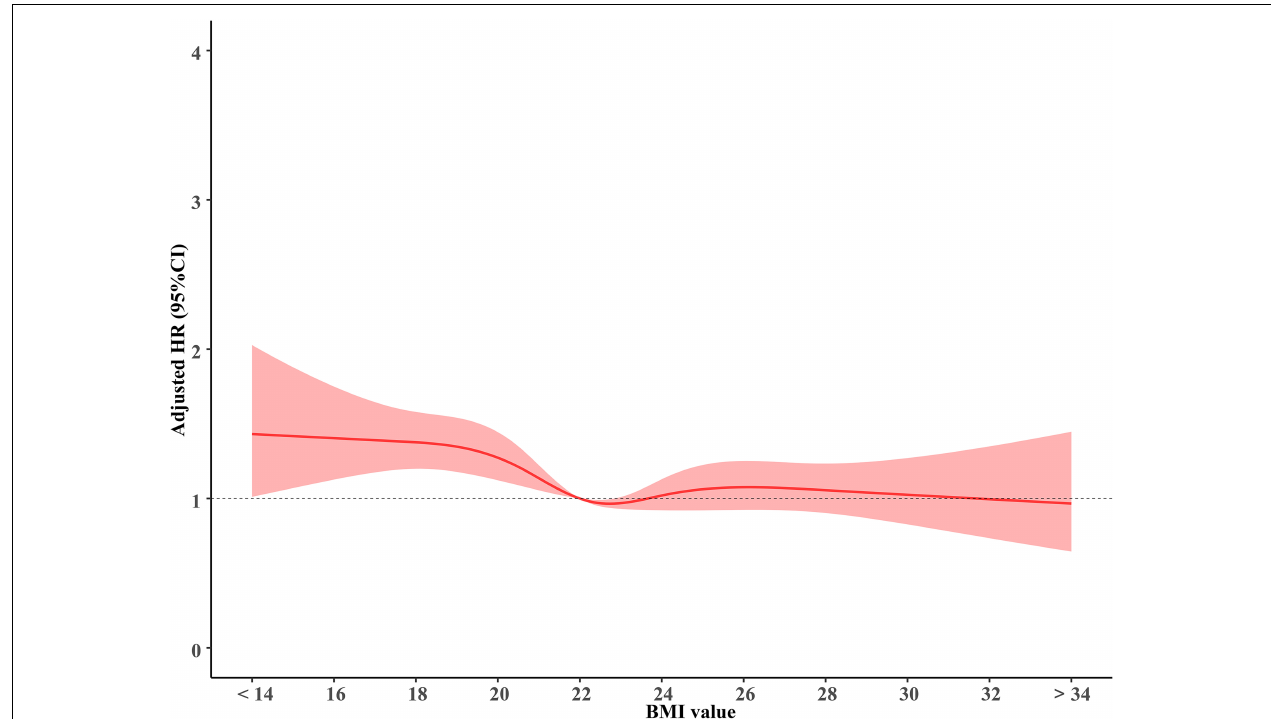
FIGURE 1 | The association of BMI with overall survival. BMI, body mass index (recorded when brain metastases was